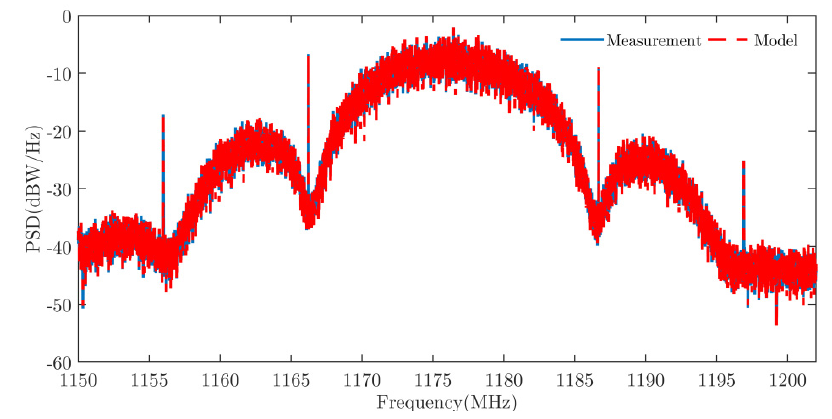
Figure 5. BIIF-5 L5 PSD.